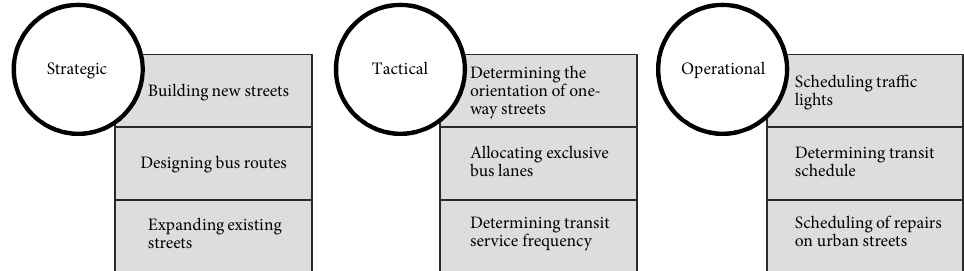
Fig. 1. Levels of decision-making process in the